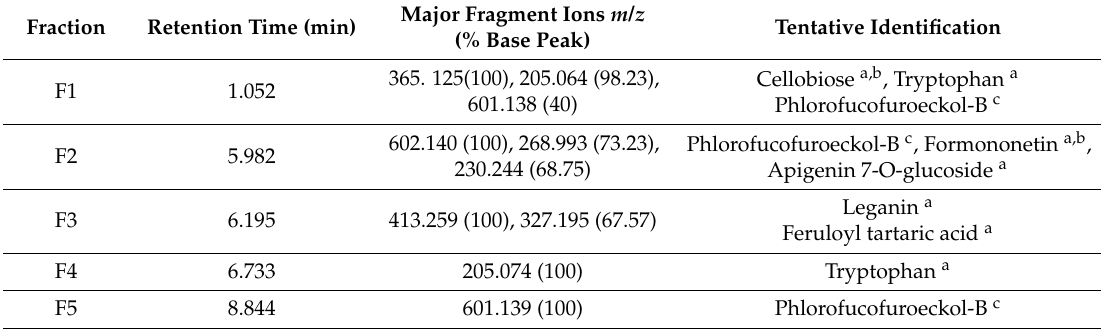
Table 5. HPLC Fractions of Polyphenol-rich extract isolated from Ecklonia arborea